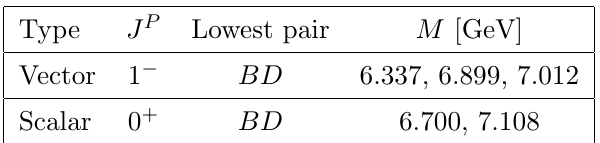
Table 2 . Lowest B + states needed for Blaschke factors with t < t bc (whose relevant two-body c threshold is indicated by \Lowest pair") for the J P channels of